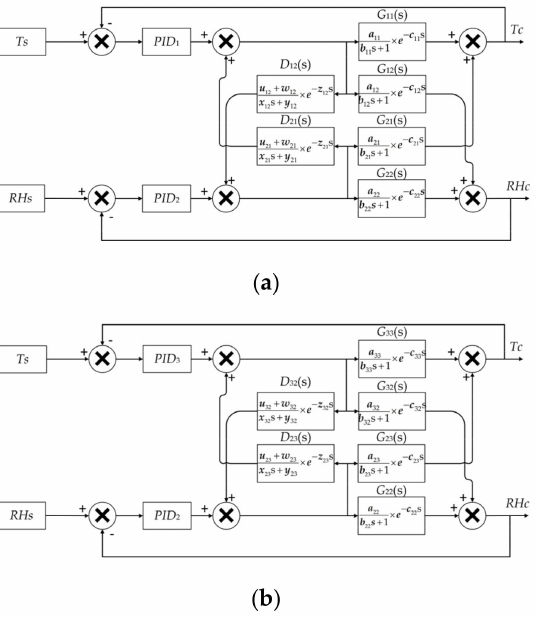
Figure 5. ( a ) The heating-humidifying system model, ( b ) the cooling-humidifying system model [16]. The model of the control system is effective in tuning the parameters of the controller, including both the feedback and feed-forward parameters, which are essential factors for a rapid and accurate control of temperature and humidity. In the actual tuning process, the parameters a , b , c of G 11 (s), G 12 (s), G 21 (s), G 23 (s) and G 33 (s) can be obtained experi- mentally [17], and the parameters u , w , x , y , z of feed-forward decoupling factors D 21 (s), D 12 (s), D 23 (s) and D 32 (s) can be solved by Equations (3) and (4). The solving process will be used for the tuning process detailed in Section 3.2. By implementing the discretized feed-forward decoupling factor differential equation into the control program, the